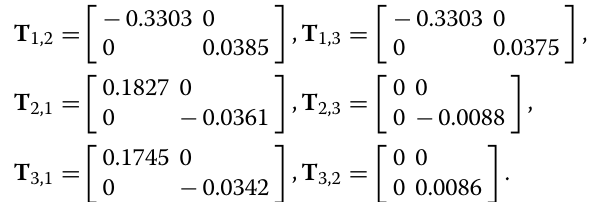
where all the λ s are within the stable region. The simula- tion results for Setting I are shown in lines with squares and triangles with left y -axis. Specifically, the line with squares is the theoretical bias derived using the bias evo- lution Eq. (10) while the line with triangles shows the bias in a mode-based Kalman filter via Monte-Carlo simula- tion. We can conclude that when all the λ s are in stable region, the bias of the mode-based Kalman filter is con- vergent and bounded. For Setting II, we use λ 2,1 = λ 3,1 = = 0.1, λ = 0, λ = 0.3, λ = 0.2 in which λ λ 1,2 1,3 3,2 2,3 2,1 , λ λ 3,1 , and 1,2 are outside the stable region. The solid line and the dashed line with right y -axis present the results for theoretical bias and actual bias generated in a mode- based Kalman filter via Monte-Carlo simulation. Note that (cid:22) (cid:22)(cid:5) (cid:22) (cid:22) (cid:4)(cid:22) (cid:22) (cid:22) x ∗ x ∗ since the actual the y -axis on the right is log k k